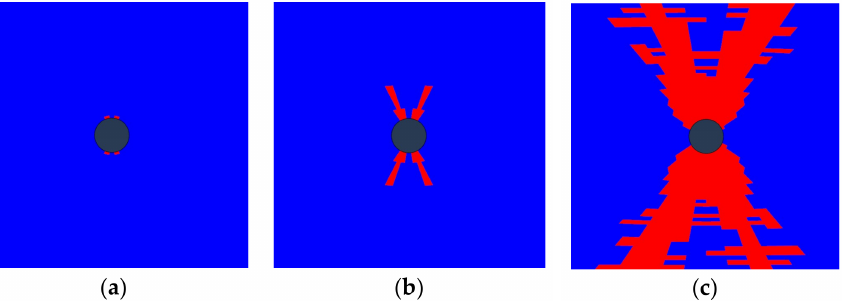
Figure 10. Fiber damage and failure paths in 0 ◦ layer of laminated plates using Hashin method ( a ) Initial damage; ( b ) Damage at 90 percent failure; ( c ) Damage at final load.